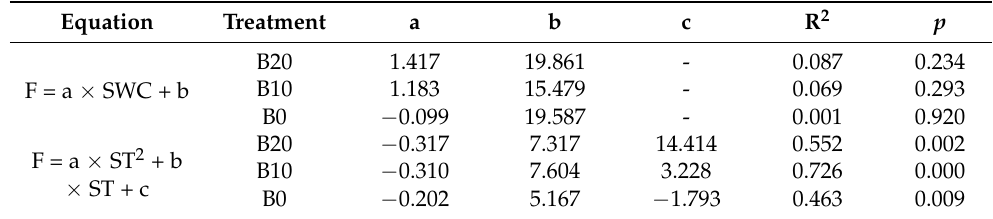
Table 2. Equations of the relationships between the CH 4 -C uptake fluxes (F) and soil water content (SWC) and soil temperature (ST) under different amounts of added biochar in wheat fields.